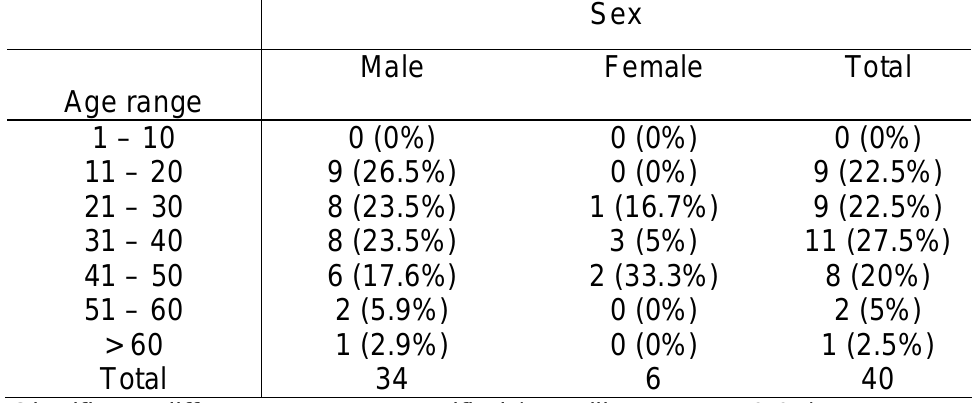
Table 2: Frequency of envenomations in Northwest counties of the Rio de Janeiro State, Brazil, in 1995, 1996 and 2000, according to age range and sex